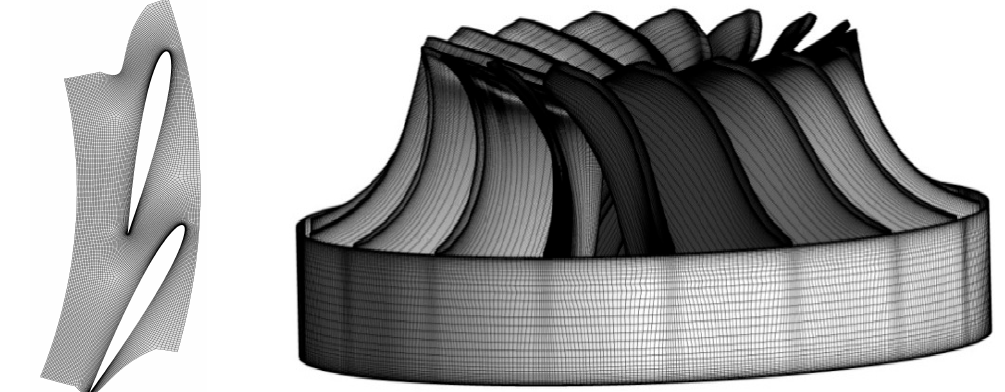
Figure 5. Hexahedral mesh of guide vane made in ICEM and Runner made in Turbogrid. ICEM: powerful meshing software.